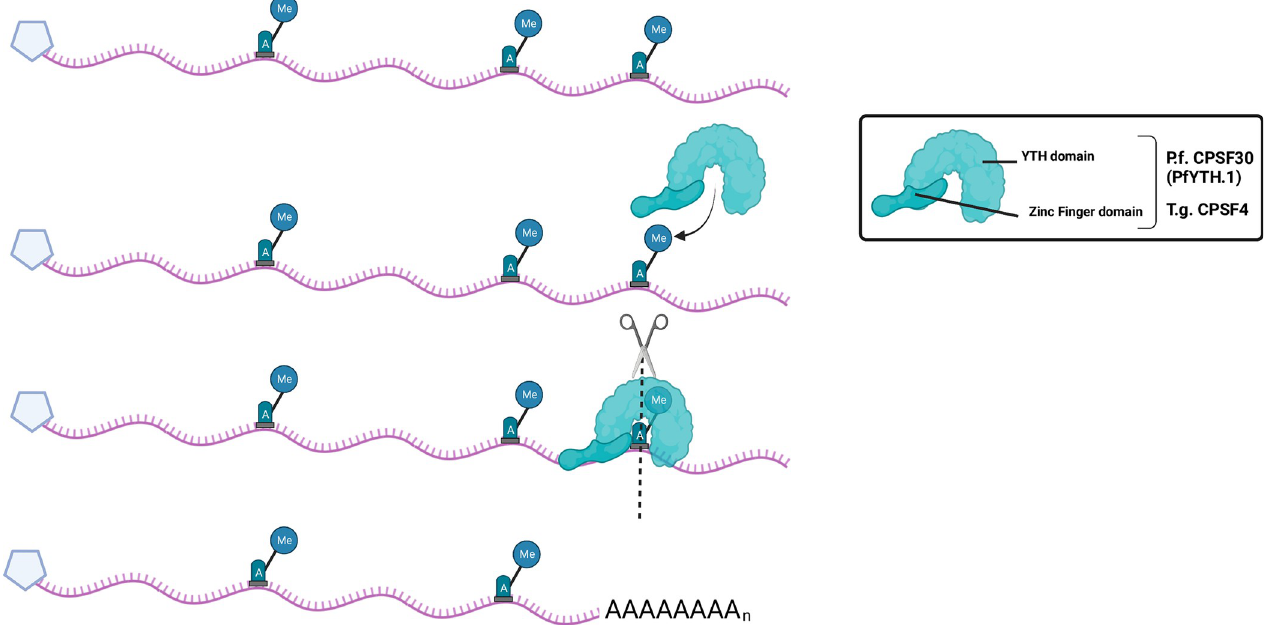
Fig 2. Model demonstrating m 6 A facilitated transcript end site recognition mediated by YTH containing protein, CPSF4 in T . gondii [71,94]. As stated in literature, where the m 6 A is installed, polyadenylation machinery may recognize the location and carry-out recruitment of associated proteins, cleavage (dotted line), and poly(A) tail addition. Created with